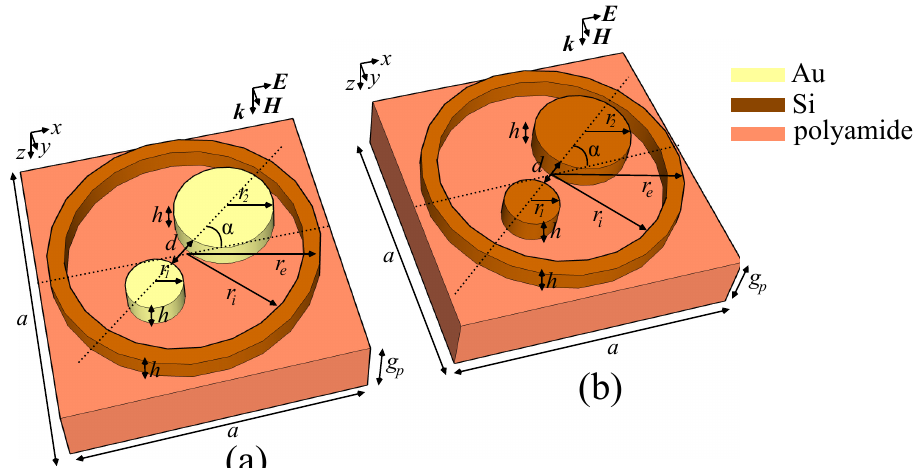
Figure 1. Layout of the proposed metasurface unit cell in ( a ) the silicon-gold and ( b ) the all-silicon configurations. The two cylinders with radii r 1 and r 2 are placed with the centers along an axis rotated with an angle α with respect to the Ox